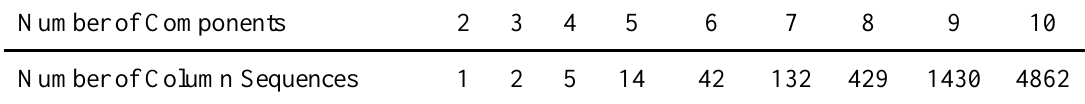
Table 2. Number or required sequences to separate a